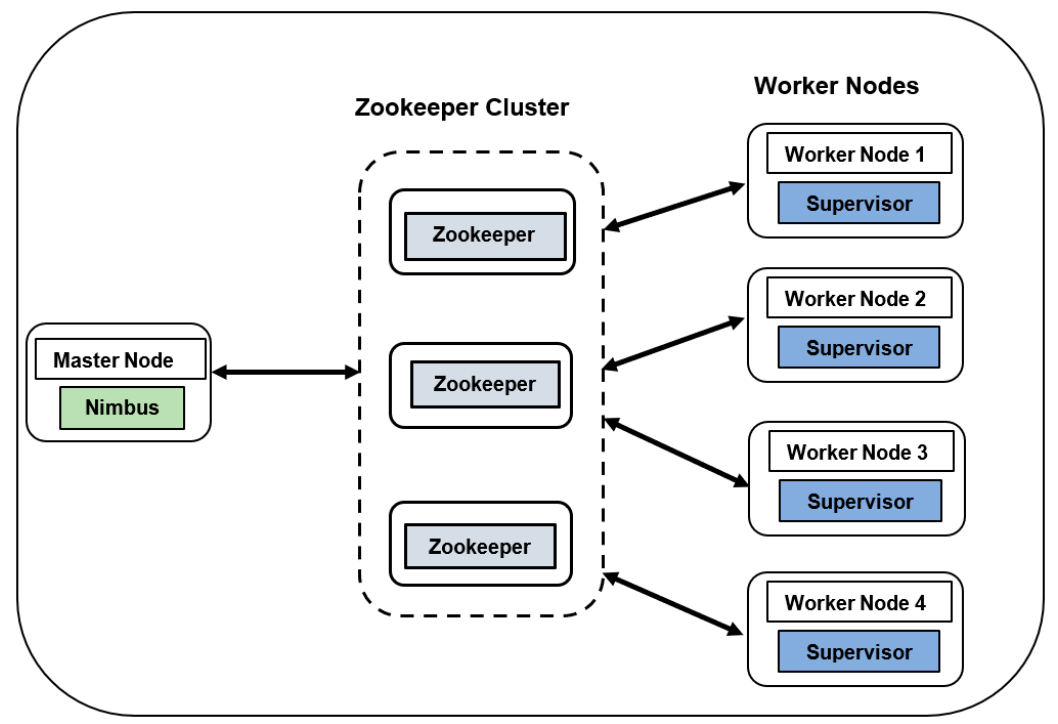
Figure 2. Apache Storm architecture.